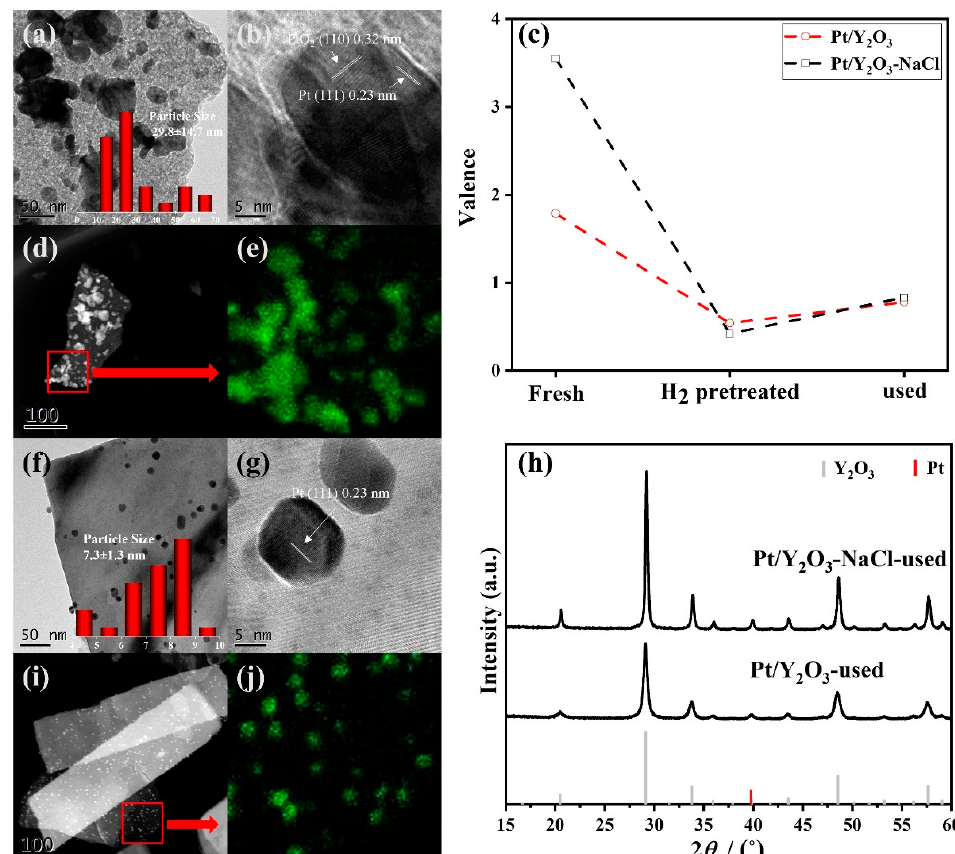
Figure 7. Structural characterization of used catalysts. TEM ( a , f ) and HRTEM images ( b , g ), and HAADF-STEM images ( d , i ) and corresponding EDS mapping results ( e , j ) of used Pt/Y 2 O 3 ( a , b , d , e ) and Pt/Y 2 O 3 -NaCl ( f , g , i , j ), chemical valence evolution obtained from the linear combination fits on XANES profiles ( c ) and XRD patterns ( h ) of Pt/Y 2 O 3 -NaCl and Pt/Y 2 O 3 catalysts.